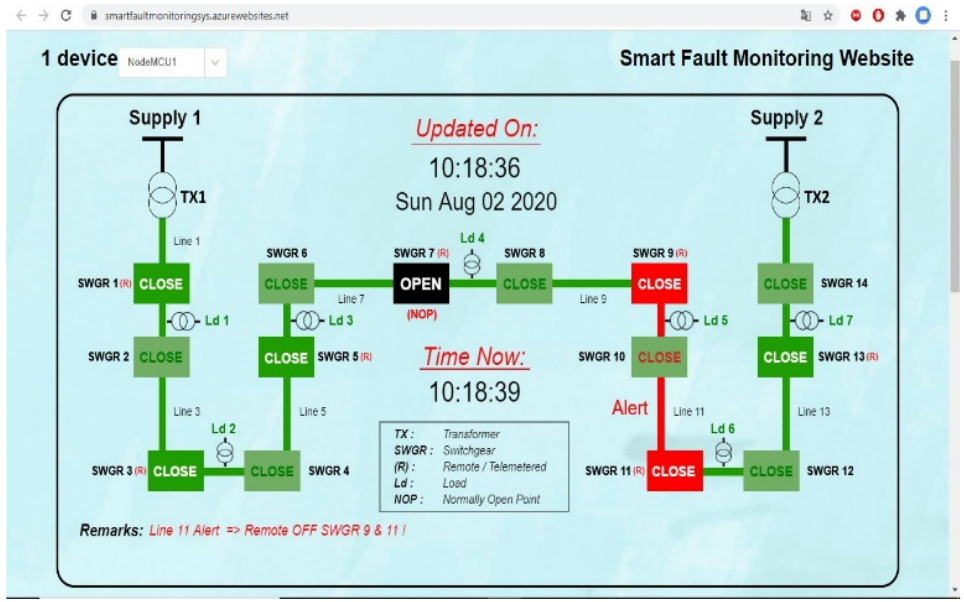
Figure 14. Smart fault monitoring website with a fault on Line 11.